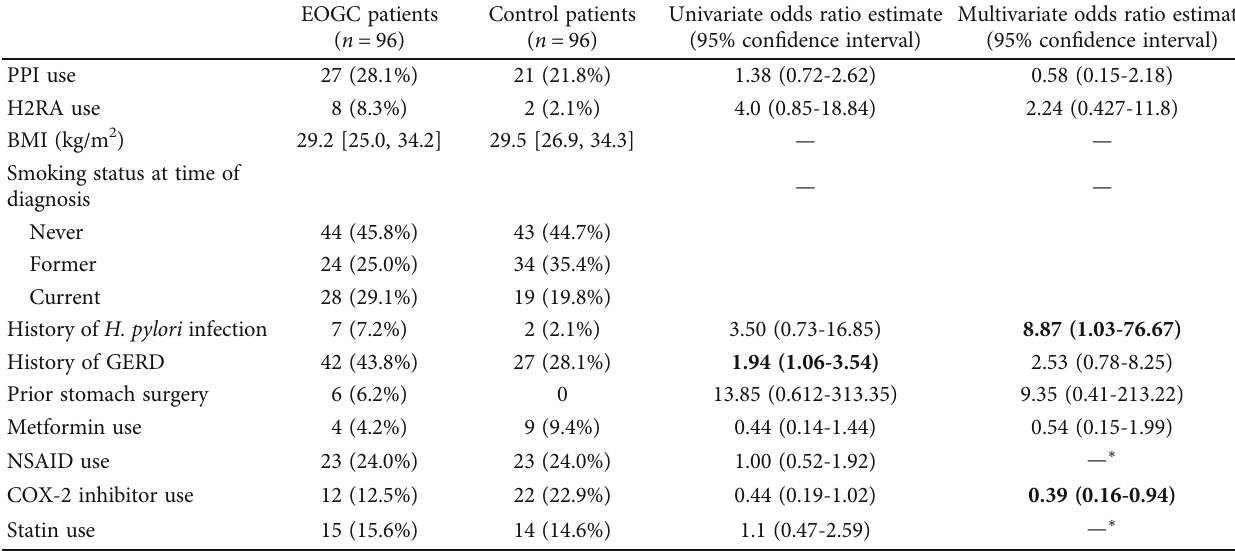
Table 2: Clinical characteristics of EOGC patient and control patient groups.